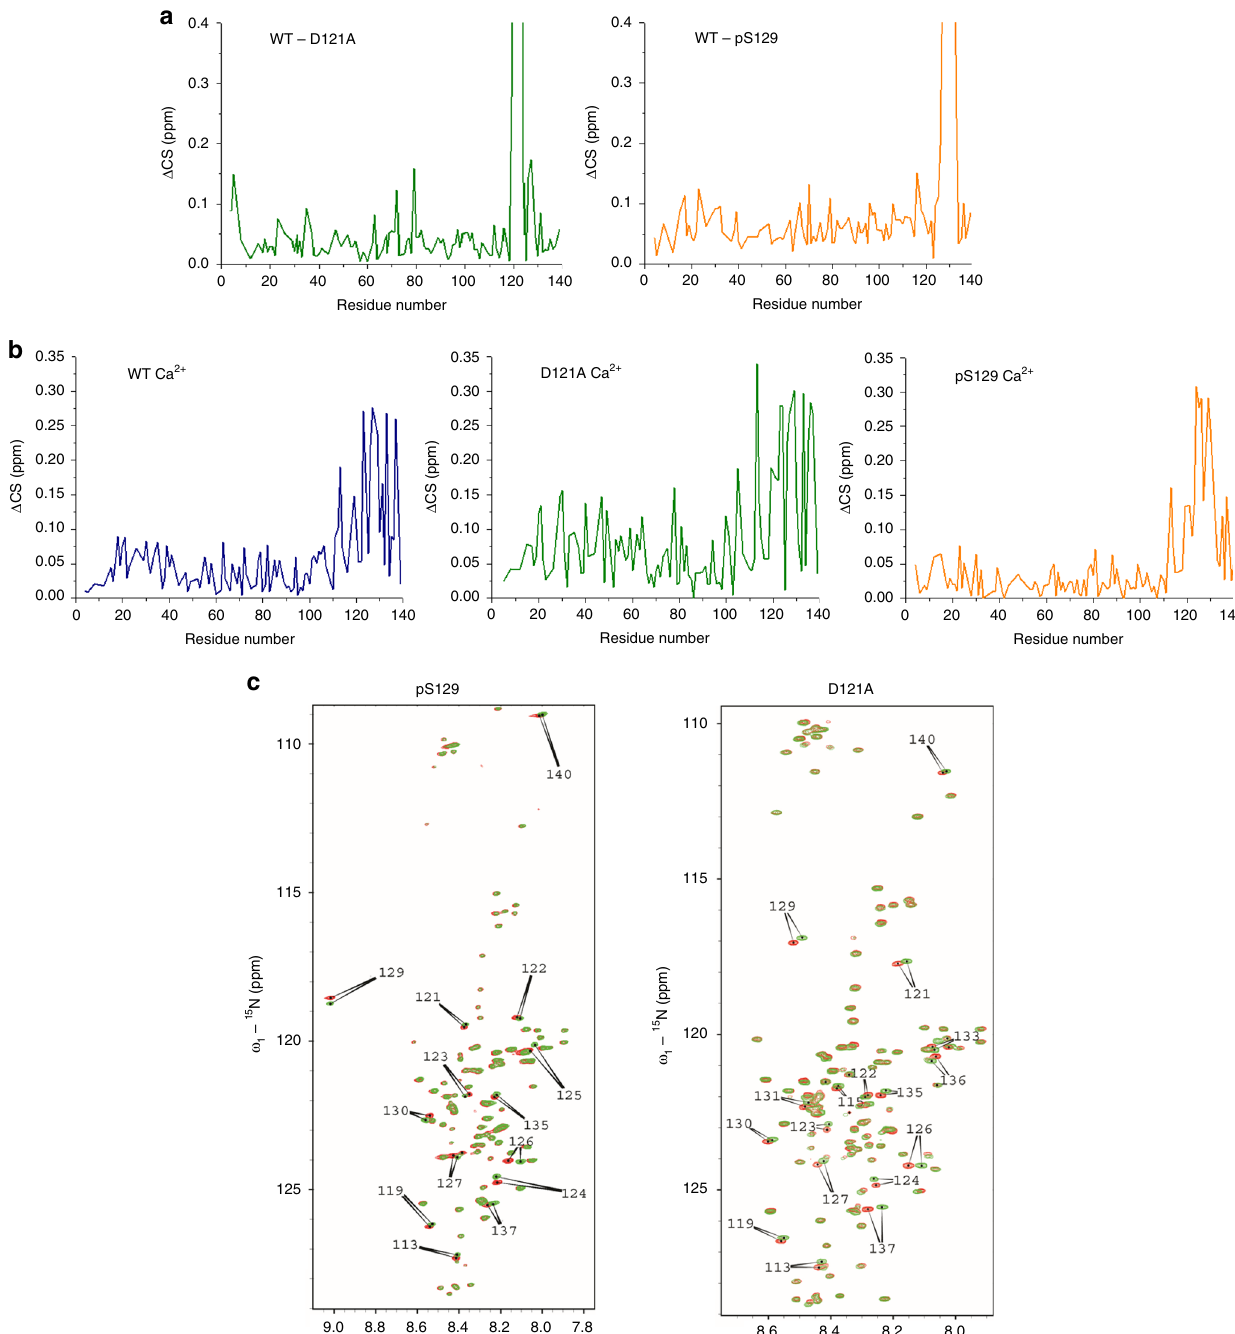
Fig. 2 1 H- 15 N spectra of WT, D121A and pS129 aSyn indicate conformational differences. a We compared chemical shift perturbations in the amide backbone of 1 H- 15 N D121A aSyn to WT aSyn (green) and pS129 aSyn to WT aSyn (yellow) in 20 mM Tris pH 7.2 (using a fi xed protein concentration of 200 μ M) and observed CSPs around the location of the D to A mutation and the PO 4 2 − of S129 at the C-terminus (for the full zoomed out spectrum see Supplementary Fig. 3.). ( b ) Signi fi cant CSPs were observed at the C-terminus upon addition of 4.2 mM calcium for all, WT (blue), D121A (green) and pS129 (yellow) aSyn. (Titration data for all concentrations of calcium are available in Supplementary Fig. 4). Higher CSPs are observed for D121A compared to WT and pS129 aSyn. c 1 H- 15 N HSQC NMR spectra of pS129 and D121A aSyn in the absence (red) and in the presence of calcium (green) (Supplementary Figs. 6 and 7 show spectra with more labels). Major CSPs in the presence of calcium are located at the C-terminus (arrows with assigned amino acid residues) in both pS129 and D121A